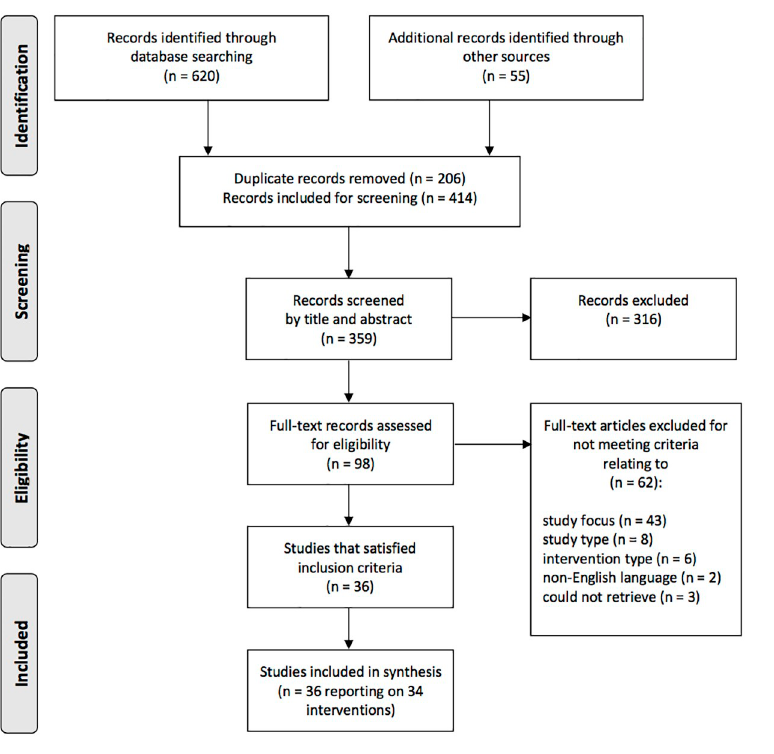
Fig 2. Study selection flow chart.